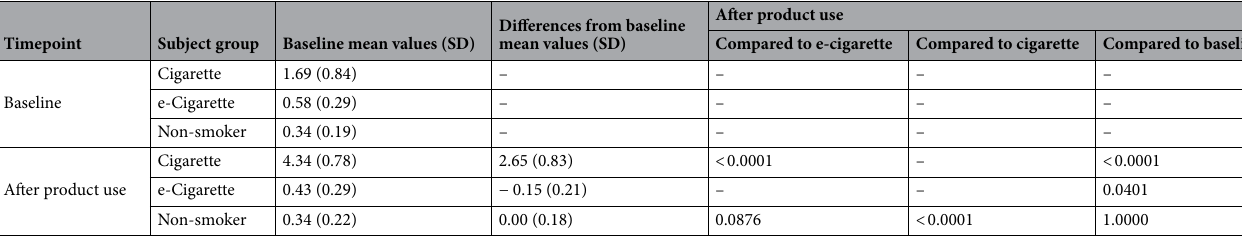
Table 4. Breath smoke intensity values before and after product use. Mean and SD values at baseline and following cigarette or ePen 3 e-cigarette use. NS values were collected at baseline and 10 ± 5 min later.